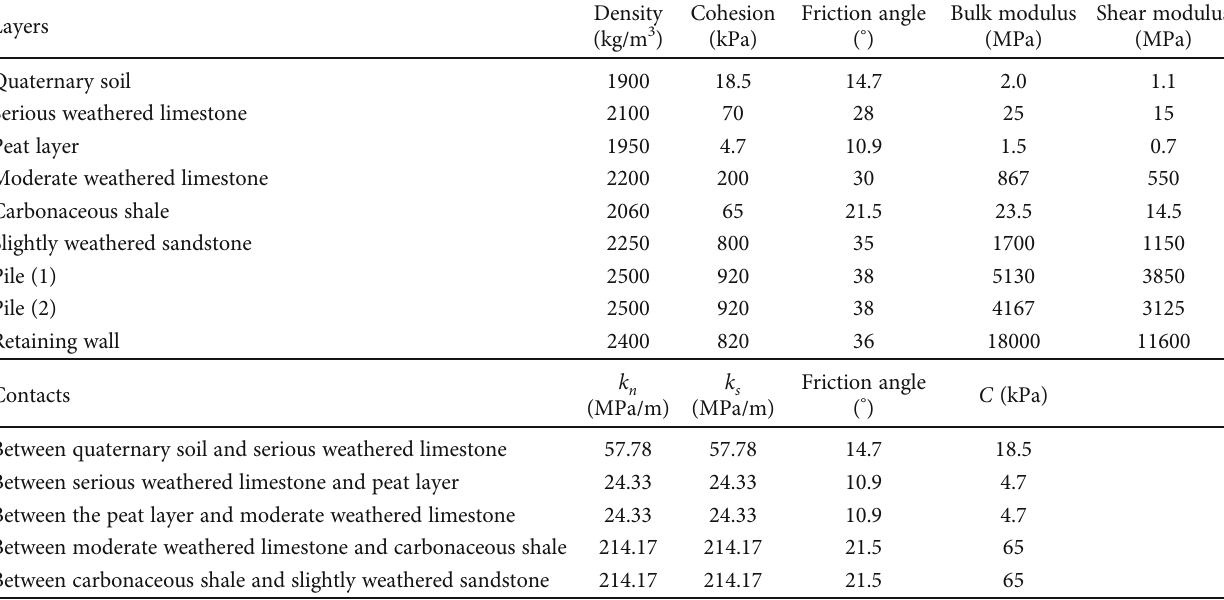
Table 1: Material